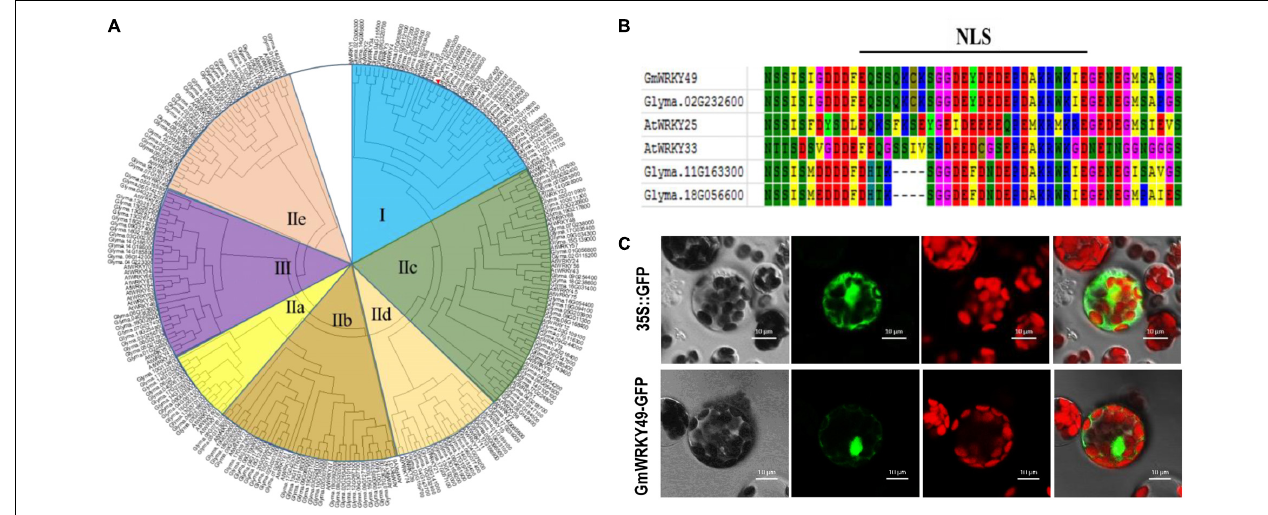
FIGURE 1 | Phylogenetic and domain analyses of WRKYs and subcellular localization of GmWRKY49 protein. (A) Phylogenetic tree inferred after deduced amino acids sequence alignment of 187 GmWRKYs and 75 AtWRKYs , including GmWRKY49 (indicated by a red arrow). All WRKY TFs were clustered into three groups named I, II, and III. Second group TFs were further classified into five subgroups (IIa–IIe). GmWRKY49 , along with AtWRKY25 and AtWRKY33 , were clustered into group I. (B) Putative nuclear localization signal (NLS); amino acid with different backgrounds shows conserved sequences. (C) Subcellular localization of GmWRKY49 protein in Arabidopsis protoplasts. Scale bar = 10 µ